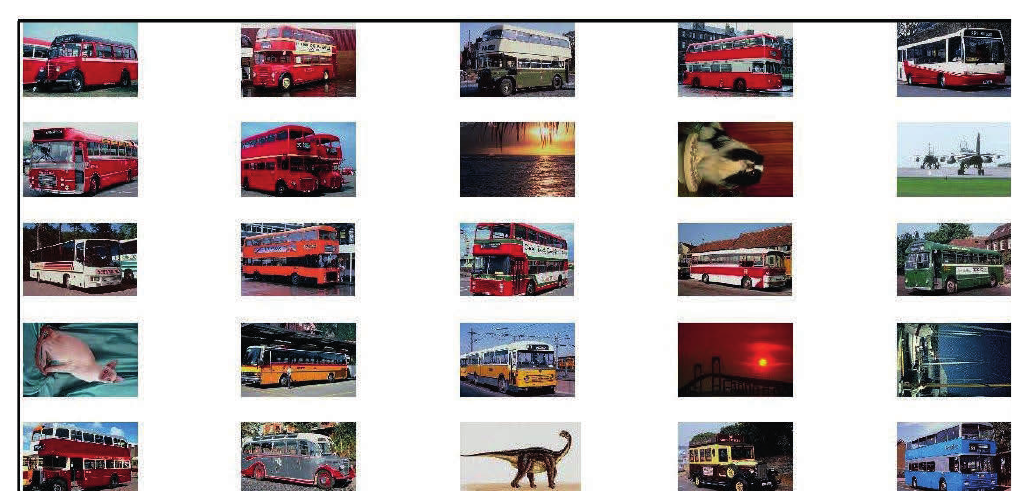
Fig. 25. Bus images retrieved at the first stage of Framework-3